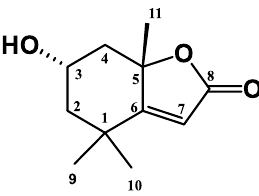
Figure 9. Structure of loliolide C-3 anomer. Table 6. 1 H- (in CD 3 OD, 600 MHz) and 13 C- APT NMR (in CD 3 OD, 150 MHz) data of compound 1 as loliolide and a comparison with literature data from Yuan et al., 2018 [36].